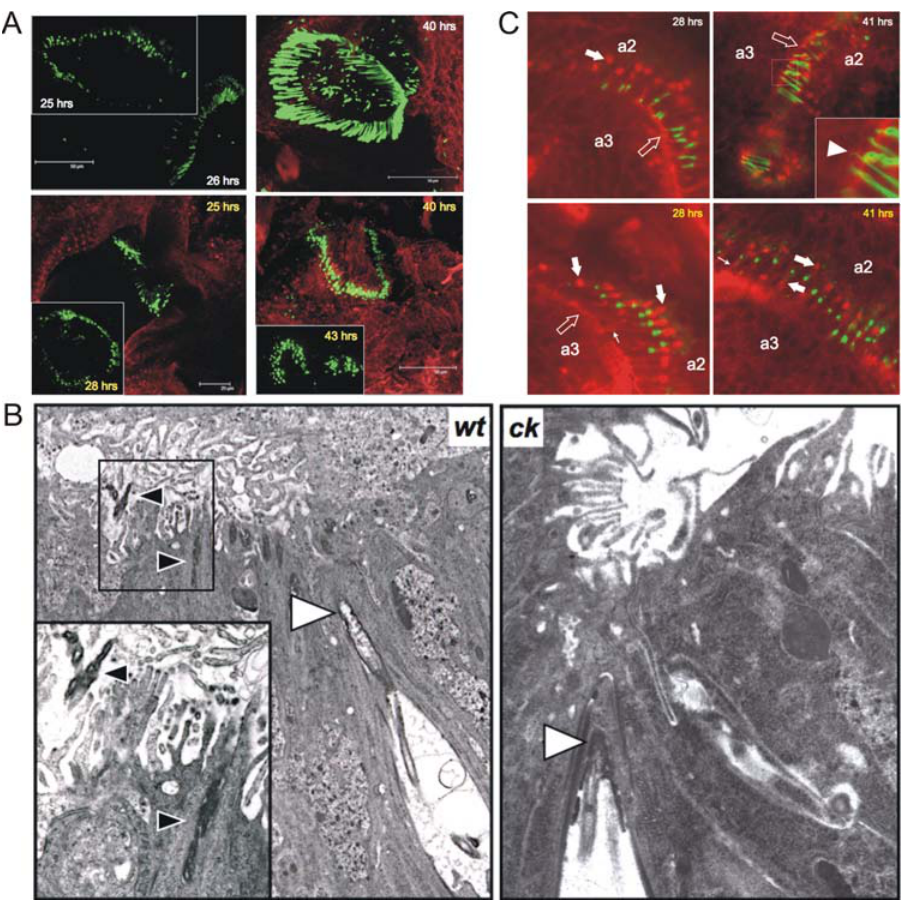
Figure 3. Scolopidia lacking ck /MyoVIIA are not attached to the a2/a3 joint during development. A: Wild type ( ck 13 /CyO ; white labels) and mutant ( ck 13 /ck 13 ; yellow labels) cultured antennal discs labelled as in Figure 2 support our finding that ck /MyoVIIA is necessary for JO organization. B: Representative EM micrographs from wild type (26 hrs APF) and mutant (28 hrs APF) antennae. Black arrowheads: dendritic caps extending beyond the a2/a3 joint boundary in controls. White arrowheads: dendritic caps at the apical levels of the scolopale space. In ck mutants the cap is more compact than in controls. Inset: magnification of the boxed area. C: Wild type ( ck 13 /CyO ; white labels) and mutant ( ck 13 /ck 13 ; yellow labels) cultured antennal discs labelled with anti-cadherin antibody. Green channel: GFP-NompA. Red channel: anti-cadherin. Arrows: cellular junction ‘‘tracts’’ in mutant discs. Open block arrows: a2/a3 boundary. Inset: enlargement of the boxed area. Arrowhead: a dendritic cap extending beyond the a2/a3 boundary. Block arrows: cell-cell junctions.